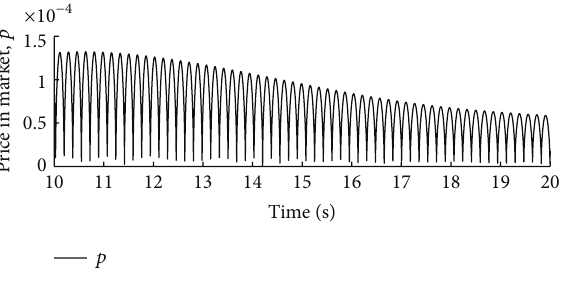
Figure 9: Price time-history response